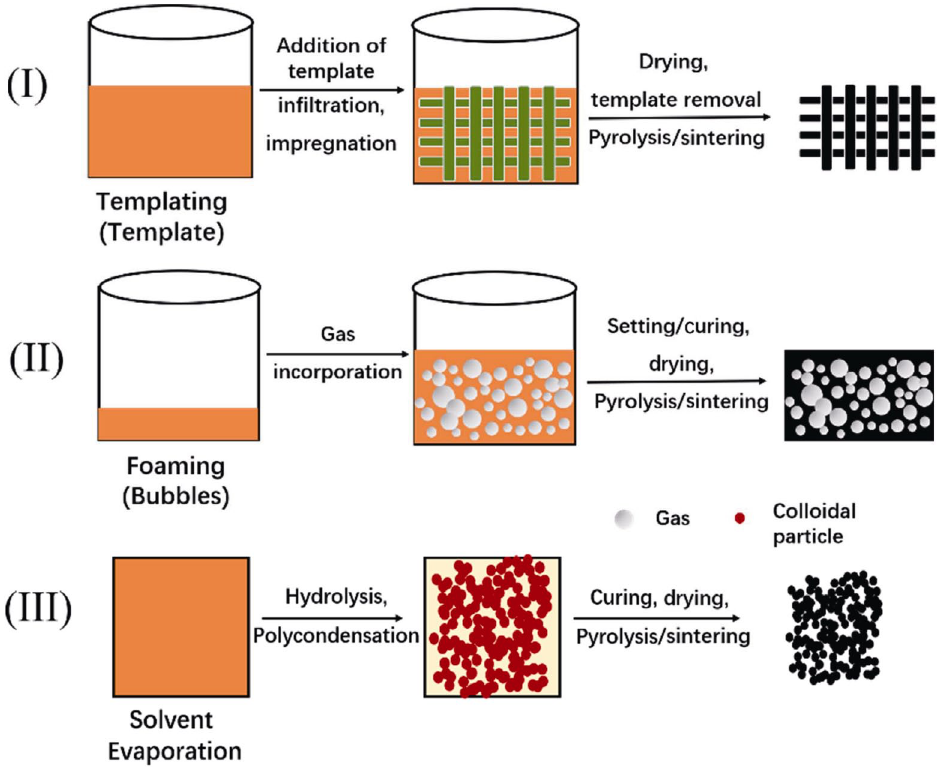
Fig. 2 Scheme of sol–gel methods for the preparation of porous